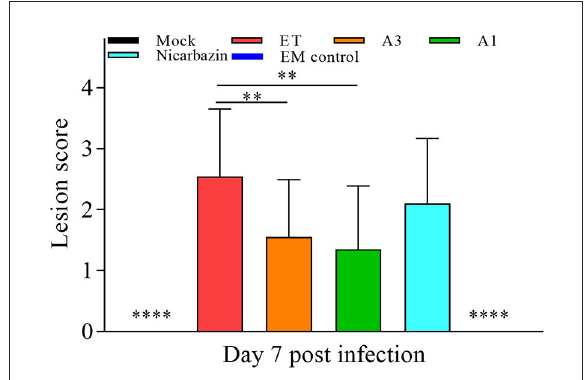
FIGURE8 Evaluation of chicken cecal lesion scores in vivo on Day 7 p.i. ** P < 0.01, **** P < 0.001 (each group compared with the ET group). A3 and A1 represent EM treatment 3 days before and 1 day after ET infection, respectively. EM, extract and essential oil mixture (non-toxic concentration of Punica granatum L., Plantago asiatica L., Bidens pilosa L., Acalypha australis L., Pteris multifida Poir, and Portulaca oleracea L. sp. Pl. extracts and Artemisia argyi Levl. et Vant. and Camellia sinensis [L.] O. Ktze essential oils); ET, Eimeria tenella